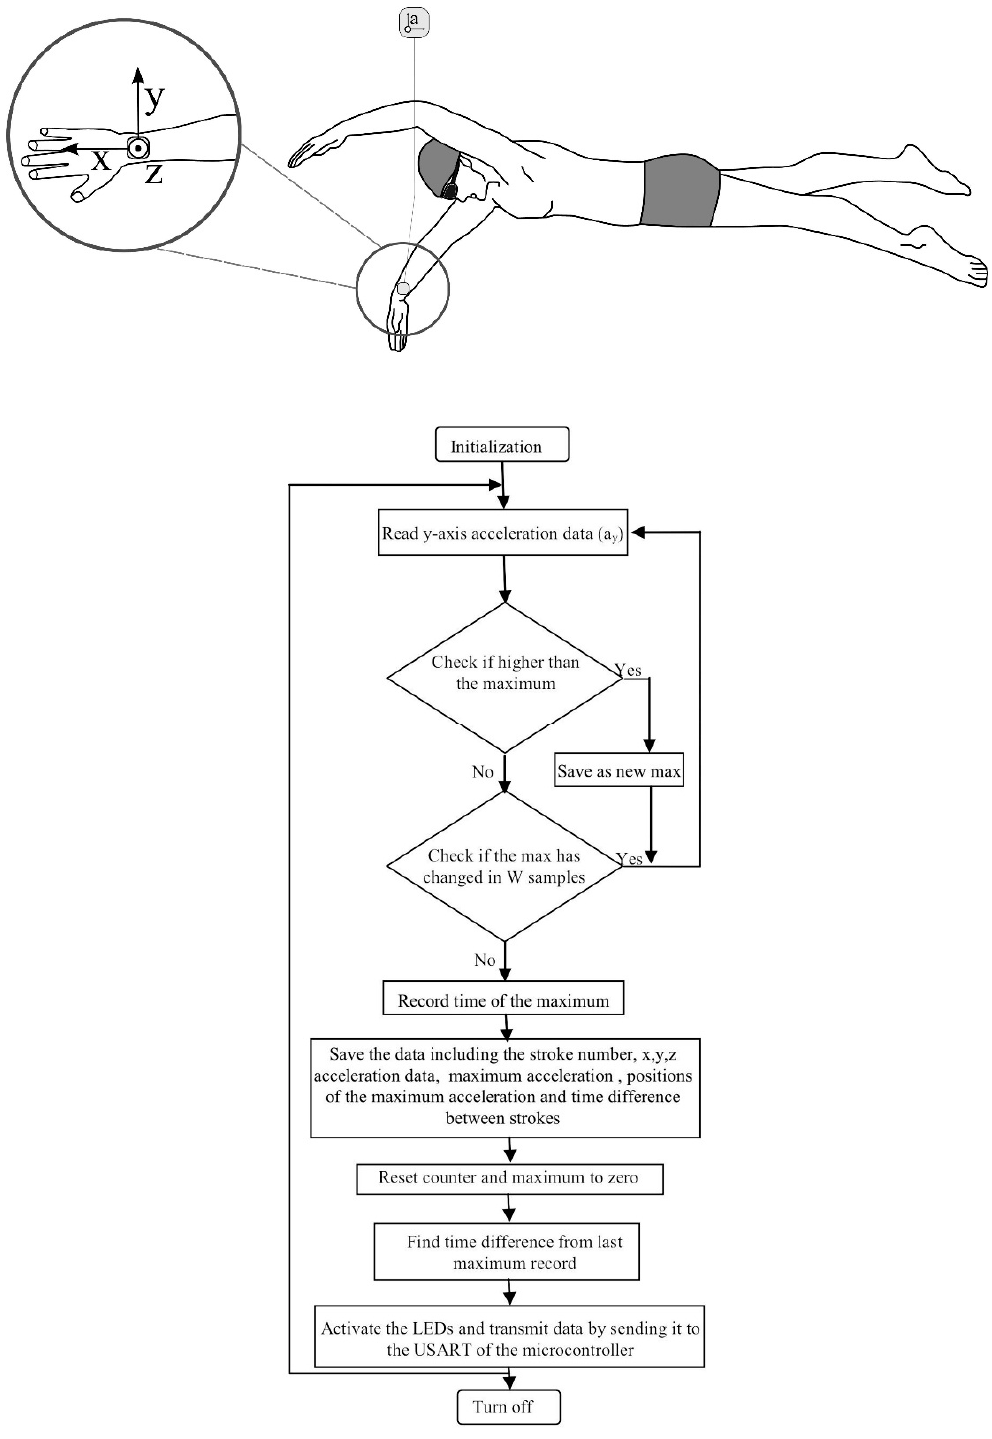
Figure 18. Flowchart of a stroke rate detection and transmission algorithm used to provide real-time feedback to a swimmer. Stroke rate is detected using a wrist worn accelerometer and information is provided to the swimmer via an LED based receiver system located in the goggles. Reproduced with permissions from Hagem, O’Keefe, Fickenscher and Thiel [77]. One study evaluated the accuracy of a zero-crossing algorithm for measuring stroke rate by comparing the performance of the algorithm against manually digitized video footage [71]. Differences with the criterion measure ranged from − 0.25 strokes per minute (breaststroke) to +0.19 strokes per minute (backstroke). Within-subject reliability testing also showed positive results, although with low subject numbers. The interclass correlation coefficient for butterfly ranged from +0.74 to 0.91, with standard error of the mean of 1.2 to 1.6%. Finally, stroke rates over four lengths of frontcrawl were compared. The overall average was the same for both automatic and manually derived data (33.5 strokes per minute) although small differences were observed when each length